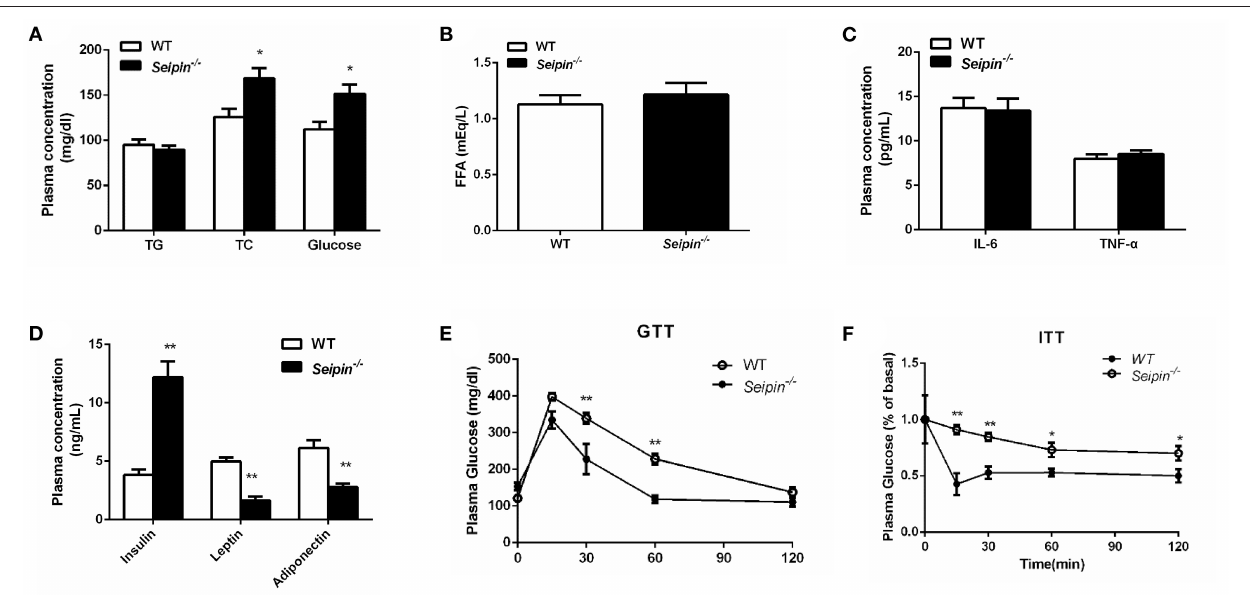
FIGURE 1 | Insulin resistance in WT and Seipin deleted mice. (A) Plasma triglyceride (TG), total cholesterol (TC), glucose content in mice fasted for 4h. (B) Free fatty acid (FFA) in mice fasted for 4h. (C) Plasma levels of IL-6, TNF- α in mice fasted for 4h. (D) Plasma insulin, leptin, adiponectin content in mice fasted for 4h. (E)